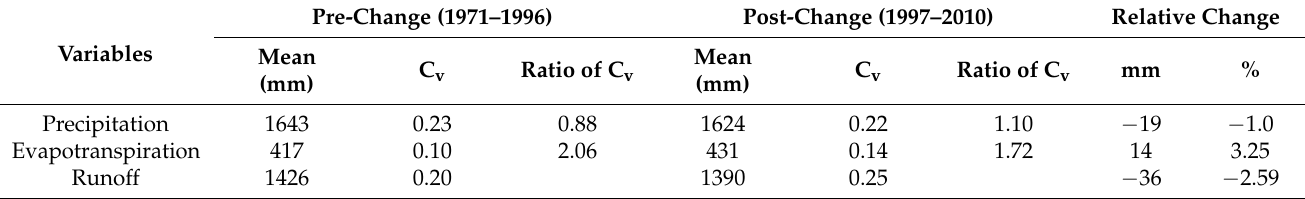
Figure 8. Change point analysis on the annual precipitation (ADP), evapotranspiration (ADET), and runoff (ADR) time series. Table 6. Descriptive statistics of the time period before and after the abrupt change in time